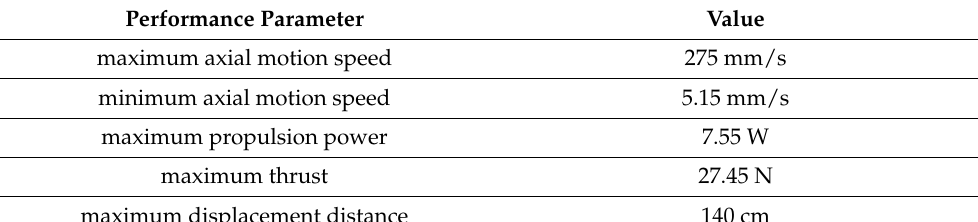
Table 1. Basic performance parameters of the